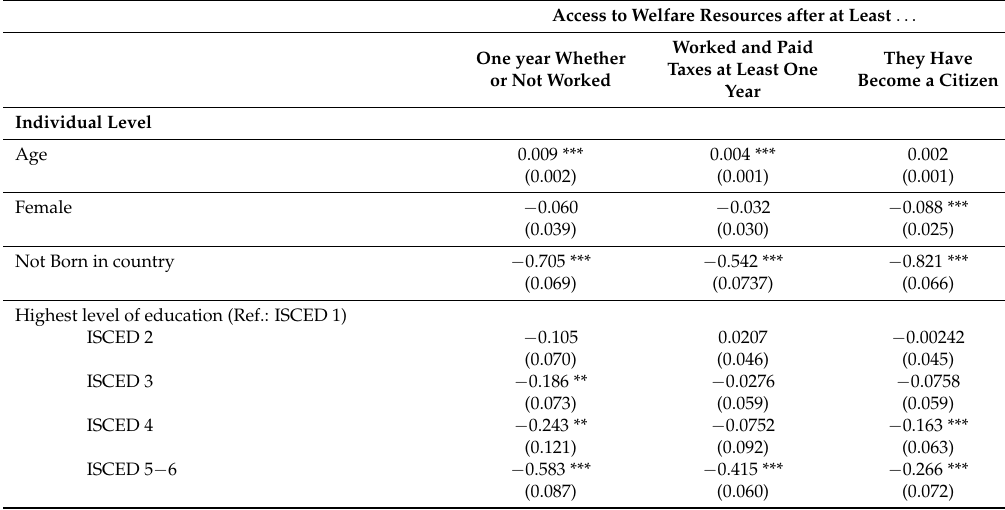
Table 4. Welfare Chauvinism, Generalized Ordered Logit